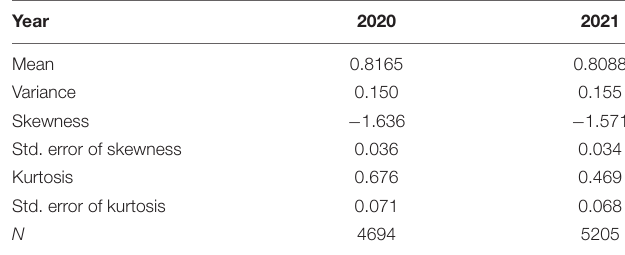
TABLE 1 | Polarization characteristics for 2020 and